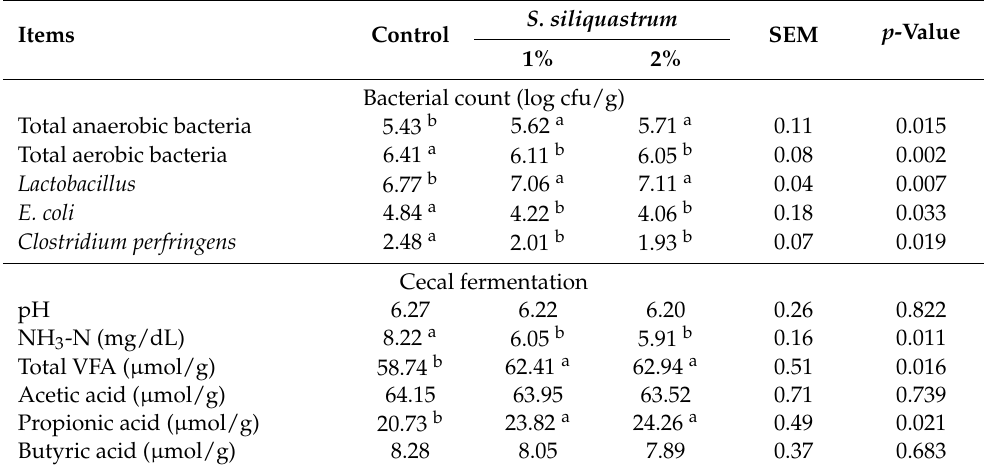
Table 6. Effect of S. siliquastrum dietary treatment on cecal fermentation in Japanese